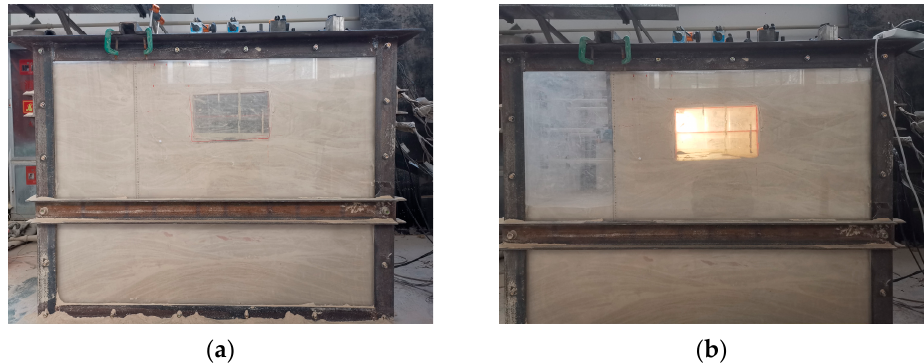
Figure 14. Model test implementation diagram. ( a ) Fill to enclosure structure top elevation, ( b ) Soil excavation-inner support erection.